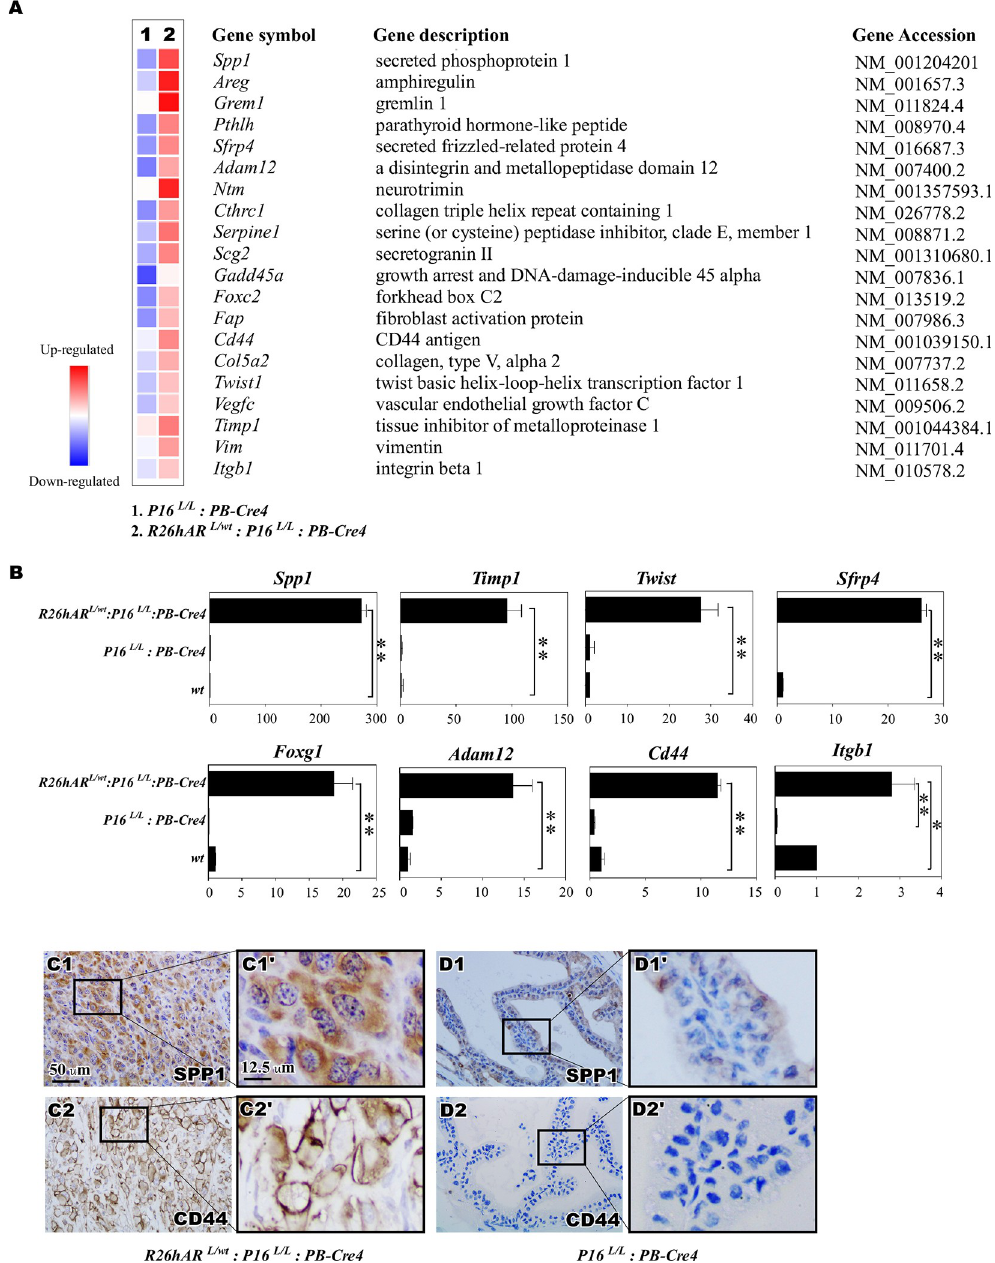
Fig 6. Co-expression of AR transgene and loss of p16 Ink4a expression induces an EMT signature. ( A) Heatmap showing a subset of differentially expressed genes (DEGs) that corresponded to an overlap of hallmark EMT genes comparing p16 L/L : PB-Cre4 and R26hAR L/wt : p16 L/L : PB-Cre4 mice. (B) qRT-PCR confirmation of the gene alterations in prostate tissues of p16 L/L : PB-Cre4 and R26hAR L/wt : p16 L/L : PB-Cre4 . The data is presented as the mean ± (SD) (n = 3) �� p < 0.005 and � p < 0.01 by student’s T test. (C-D) Representative view of IHC images of adjacent prostate tissue sections of sarcomatoid carcinoma lesion from the R26hAR L/wt : p16 L/L : PB-Cre4 mice (C1-C2) and p16 L/L : PB-Cre4 mice (D1-D2) and their magnified views (C1’-D2’). Scale bar = 50 μ m or 12.5 μ m. provide a molecular basis for the effect of transgenic AR expression and p16 Ink4a deletion in prostate cancer progression.